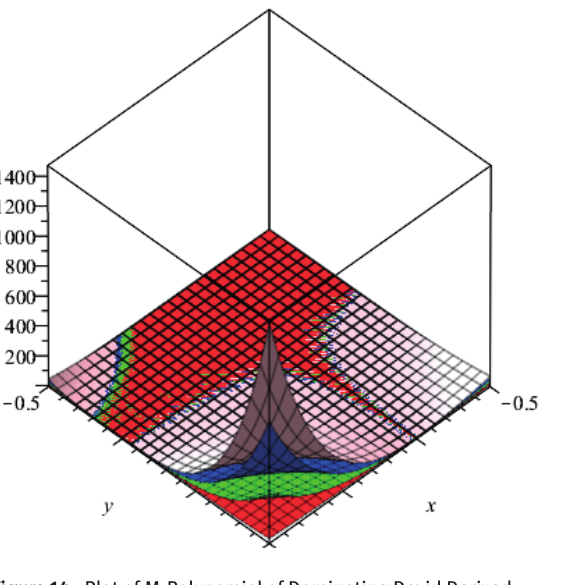
Figure 14: Plot of M-Polynomial of Dominating David Derived Network of second